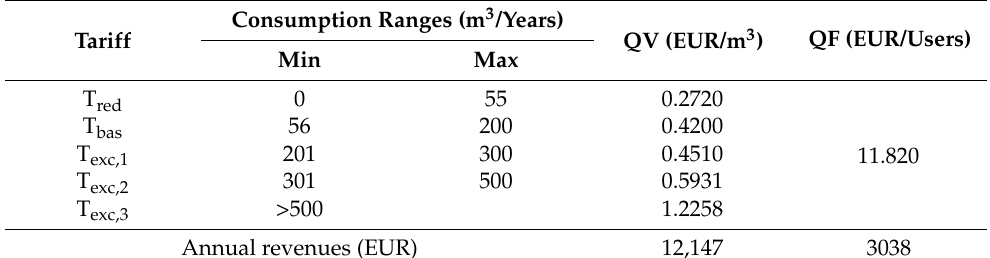
Table 2. Water tariffs and consumption ranges adopted by the operator following the application of the requirements introduced by the TICSI standard and considering the proposed optimization model.